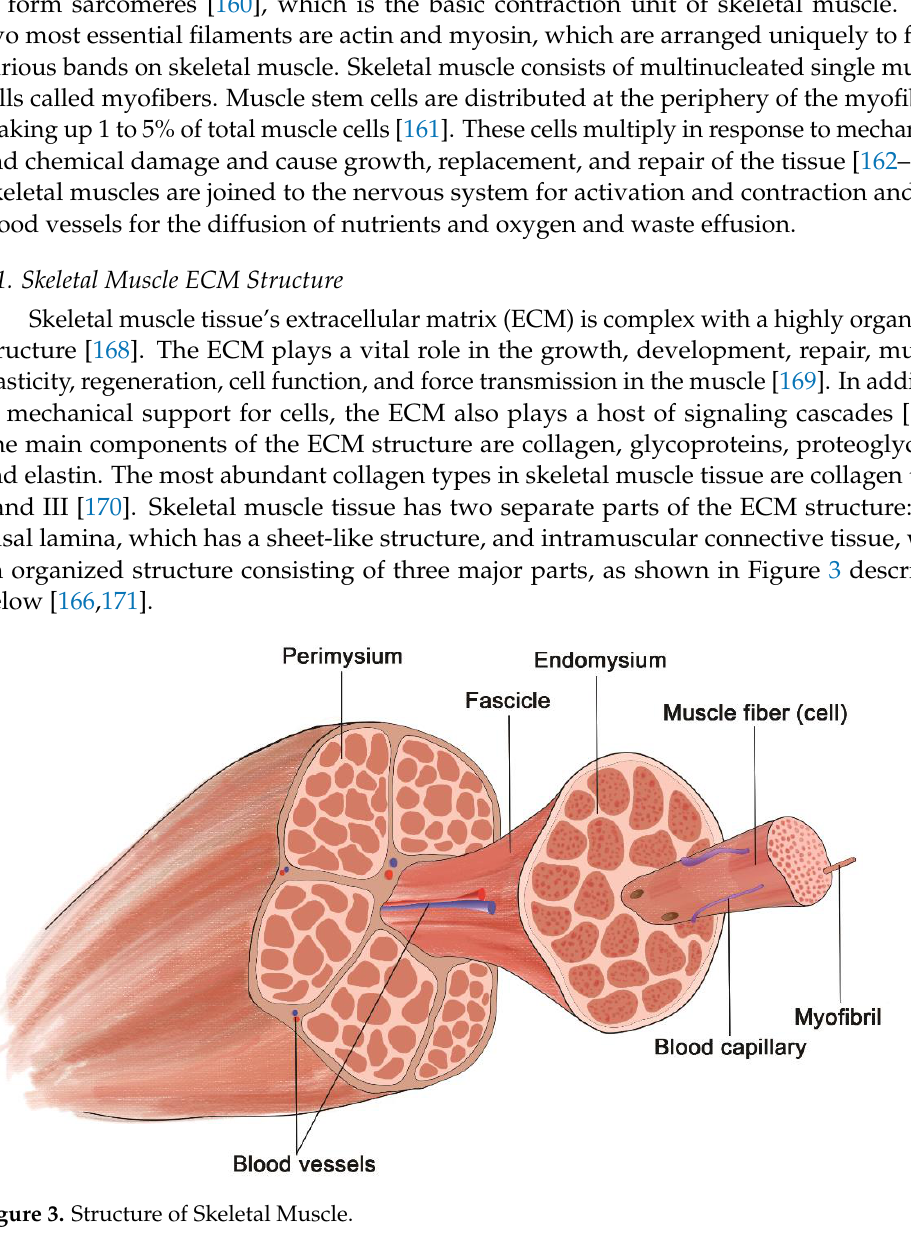
Figure 3. Structure of Skeletal